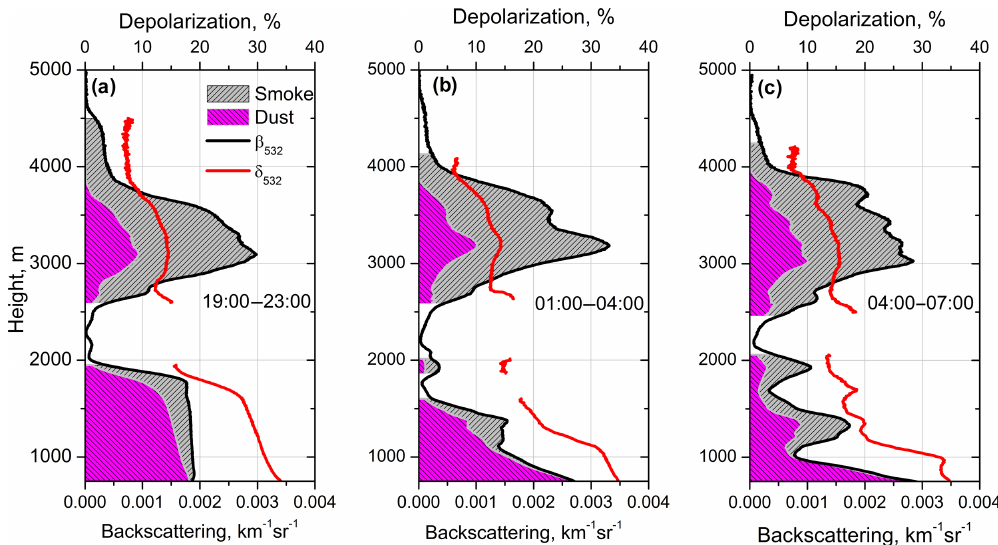
Figure 11. Contributions of dust and smoke to the total backscattering coefficient β 532 together with particle depolarization ratio δ 532 for three temporal intervals on 24–25 December 2015. Magenta and grey regions correspond to dust and smoke contribution to total scattering + β s β 532 = β d 532 532